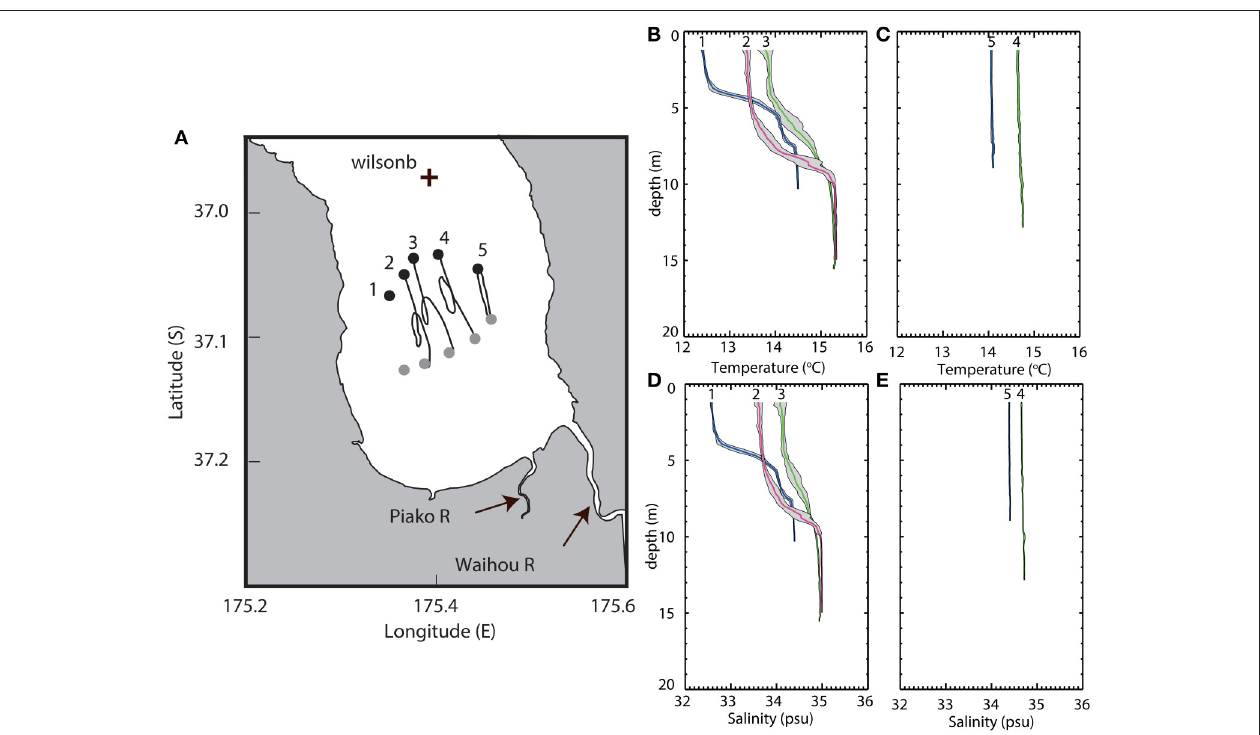
FIGURE 8 | Drifter tracks and scamp profiles in the Firth from June 14 to 15, 2012. Drifter tracks are shown in (A) along with deployment (gray) and recovery (black) locations. Numbering 1–5 corresponds to scamp profiles of temperature and salinity shown in (B–E) from drifter recovery locations. Note that GPS data was not recovered from the western-most drifter.